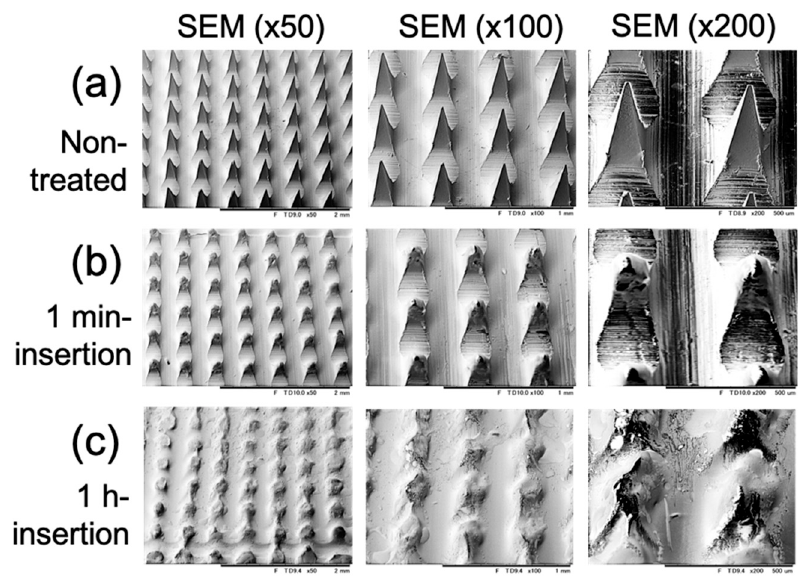
Figure 4. The images of microneedle patch ( a ) before; ( b ) after 1 min; and ( c ) after 1 h of insertion into porcine cadaver skin. The images were performed with different scales by using SEM.